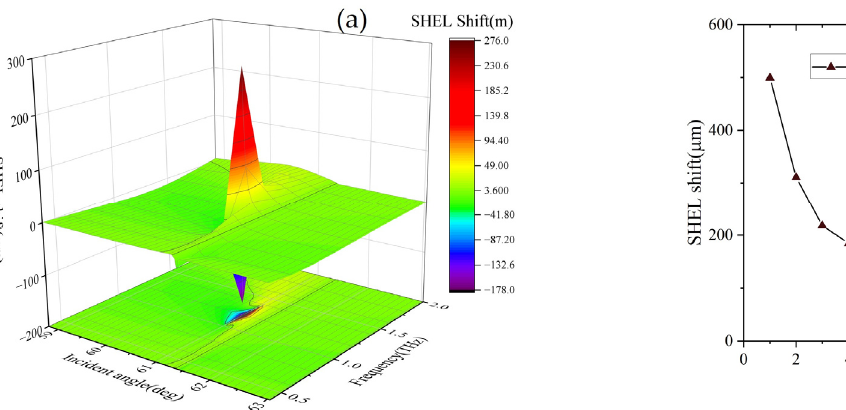
Figure 9. ( a ) Three-dimensional distribution of the beam centroid displacement of SHEL at different frequencies with the incident angle, when the number of periods was seven; ( b ) SHEL shift versus number of periods.